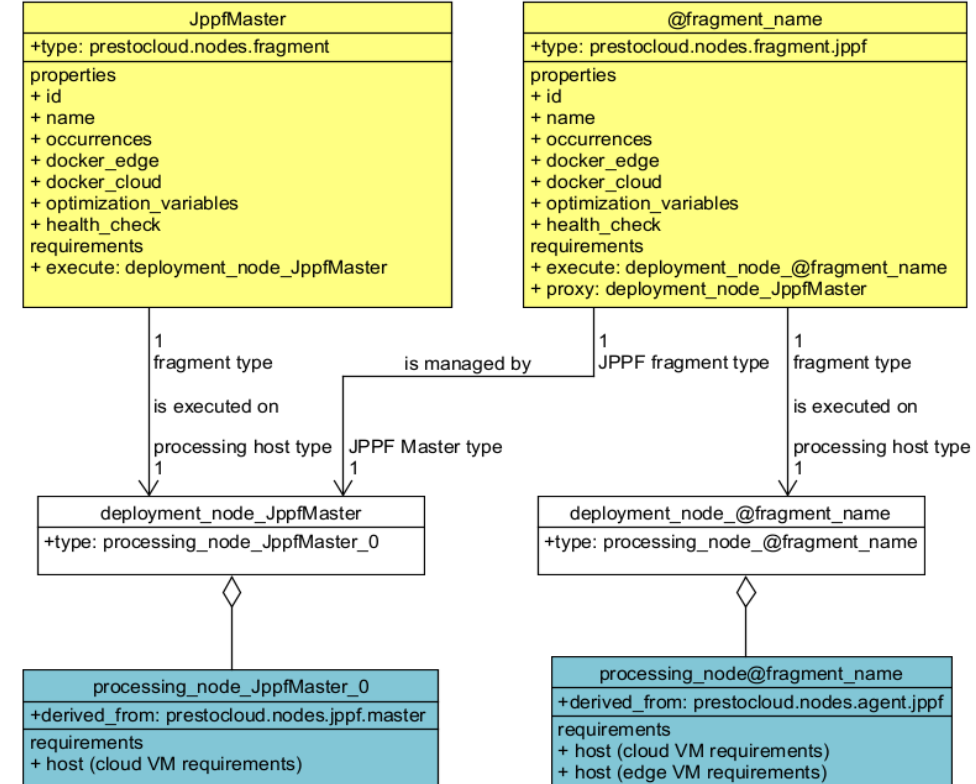
Figure 6. The relationships between the fragment, processing, and mapping nodes of the JPPF master and the JPPF tasks (fragments).